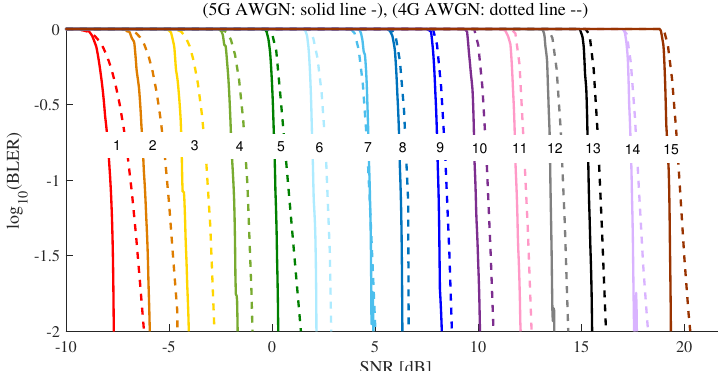
Figure 5. The BLER comparison between 4G AWGN and 5G AWGN.